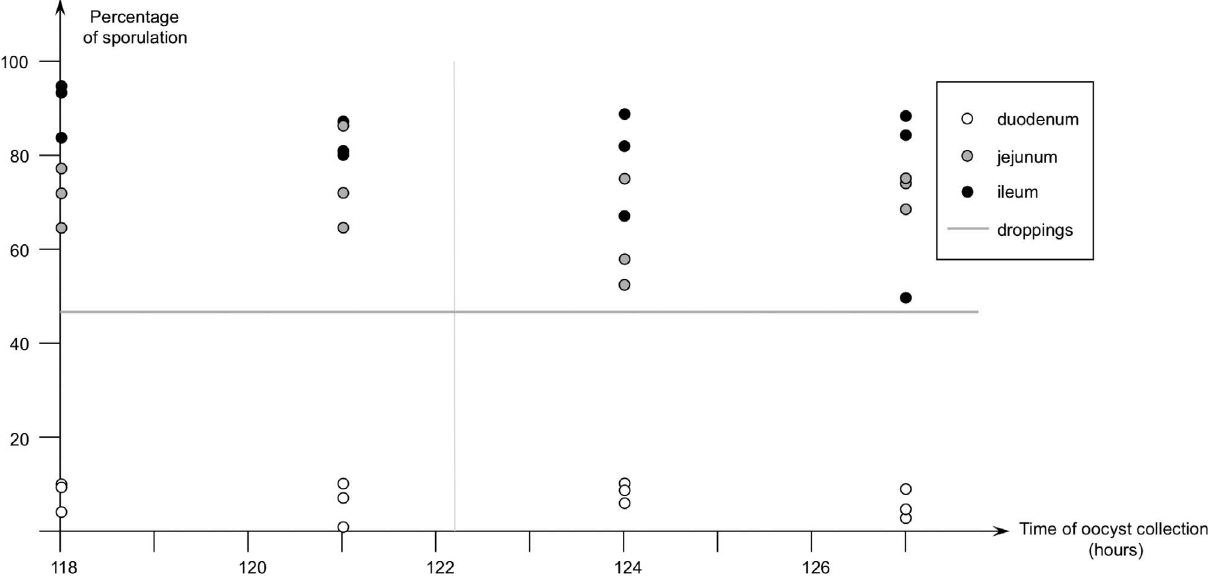
Figure 2. Second study with Eimeria meleagrimitis - percentage of sporulation depending on time of oocysts of E. meleagrimitis (PM3 strain) collected in three birds at each time in the duodenum, midgut and lower ileum (white, grey and black dots, respectively), compared with percentage of sporulation of oocysts collected in the droppings 144 h after infection (horizontal